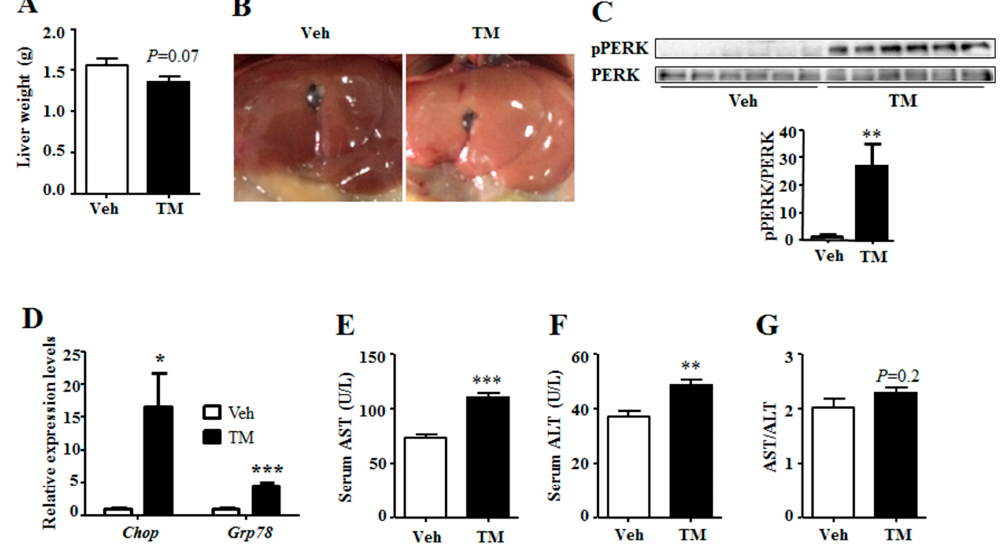
Figure 1. Tunicamycin induced hepatic endoplasmic reticulum (ER) stress and impaired liver function. 7-month-old mice were injected intraperitoneally with vehicle or 1 mg/kg tunicamycin. Livers were collected 24 h after injection under fed condition. N = 6 per group. ( A ) Liver weight at harvest; ( B ) Liver morphology; ( C ) Phosphorylation level of PERK in the liver; ( D ) Expression levels of ER stress indicator genes in the liver; ( E ) Serum level of AST; ( F ) Serum level of ALT; ( G ) The ratio of serum AST to ALT. Data were shown as mean ± SEM. Veh, vehicle; TM, tunicamycin. * p < 0.05, ** p < 0.01, *** p < 0.001 TM vs. Veh.